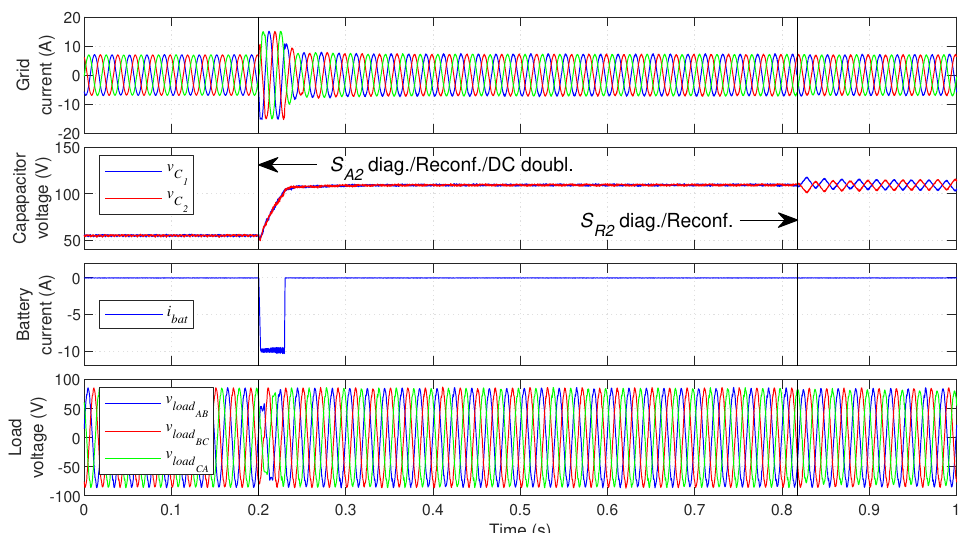
Figure 27. Normal and fault-tolerant UPS operation when OC faults occur in IGBTs S R 2 and S B 2 of the grid-side and load-side